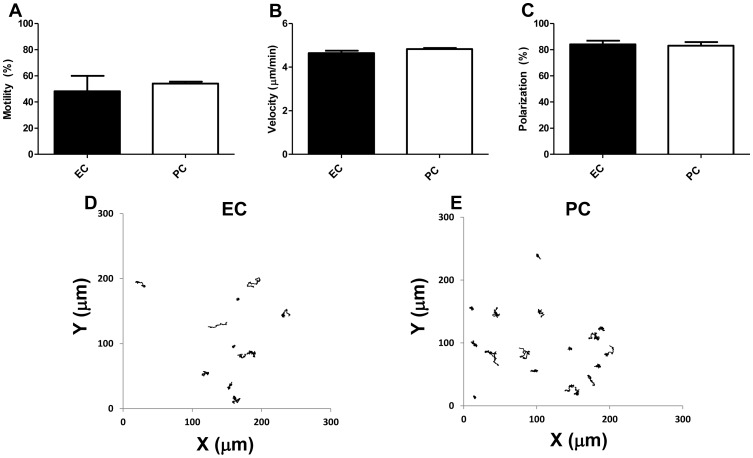
Neutrophil motility, polarization, and velocity.Freshly isolated neutrophils were seeded onto EC or PC monolayers (activated for 4 hr with IL-1β) in Sykes-Moore chambers and neutrophil (A) motility, (B) polarization, (C) velocity, (D) movement on EC and (E) movement on PC was time-lapse captured for 15 min. Bars represent average motility/polarization/velocity ± SEM.